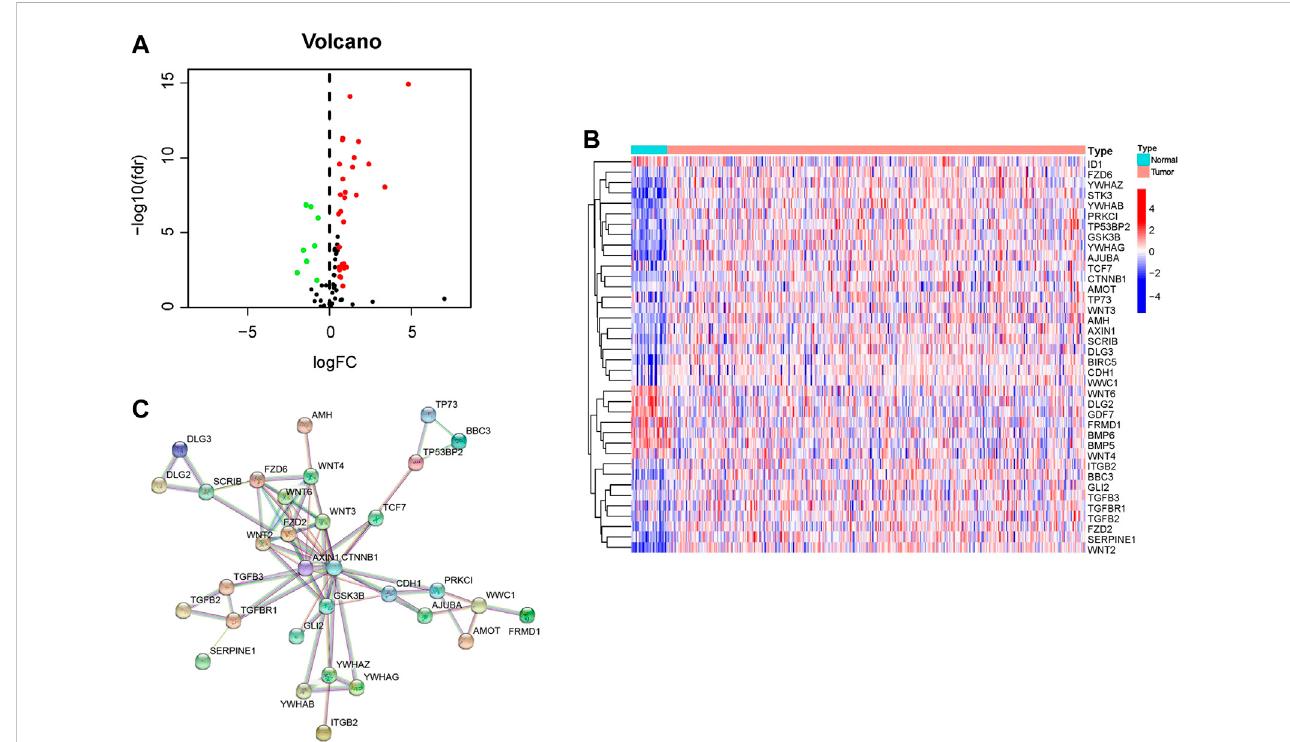
FIGURE 1 Identi fi cation of HSPRGs between GC and normal tissues. (A) Volcano plot depicting up-regulated differentially expressed HSPRGs in red, down- regulated differentially expressed HSPRGs in green, and non-signi fi cant genes in black. (B) Heatmap of differential expression HSPRGs. (C) The protein interaction biological relationship network of